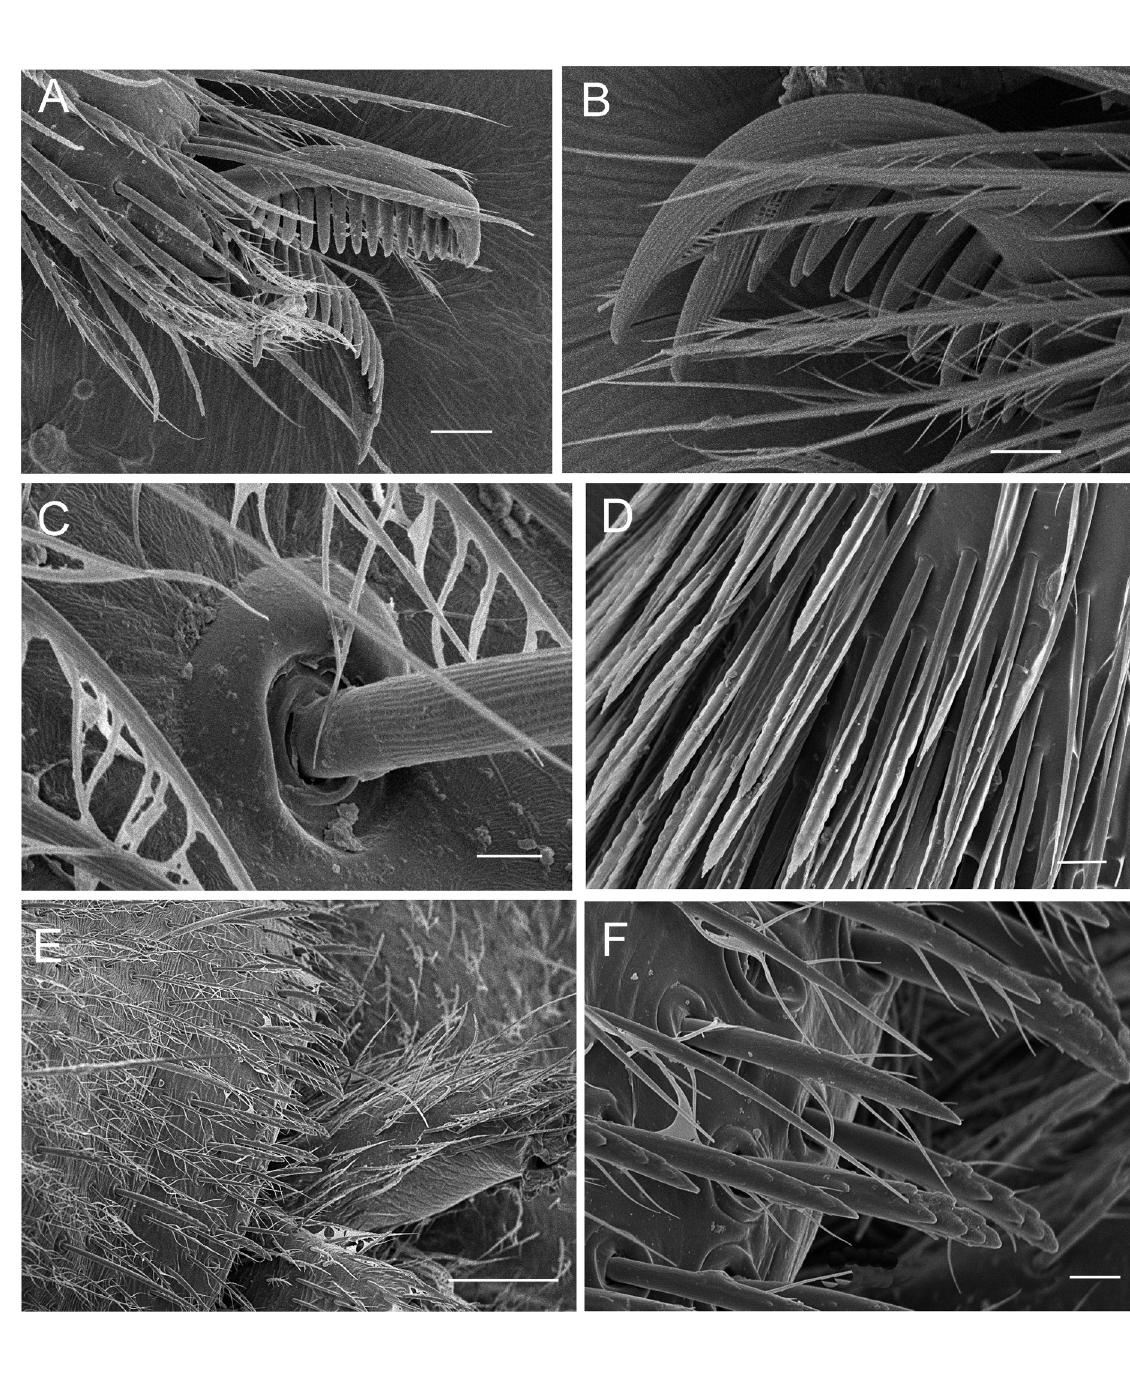
Fig. 3. Scanning electron micrographs. A . Cambonilla symphonia Jocqué & Henrard gen. et sp. nov., male paratype (RBINS IG 33.889/009). B–F . Cambonilla securicula Jocqué gen. et sp. nov. male paratype (RBINS IG 33.889/005) A . Tarsal claws of leg I, prolateral view. B . Tarsal claws of leg III, retrolateral view. C . Hinged hair on T I. D . Chisel shaped setae on Mt III. E . PVS, ventral view. F . As preceding, detail. Scale bars: A–B, D = 20 µm; C = 5 µm; E = 100 µm; F = 10